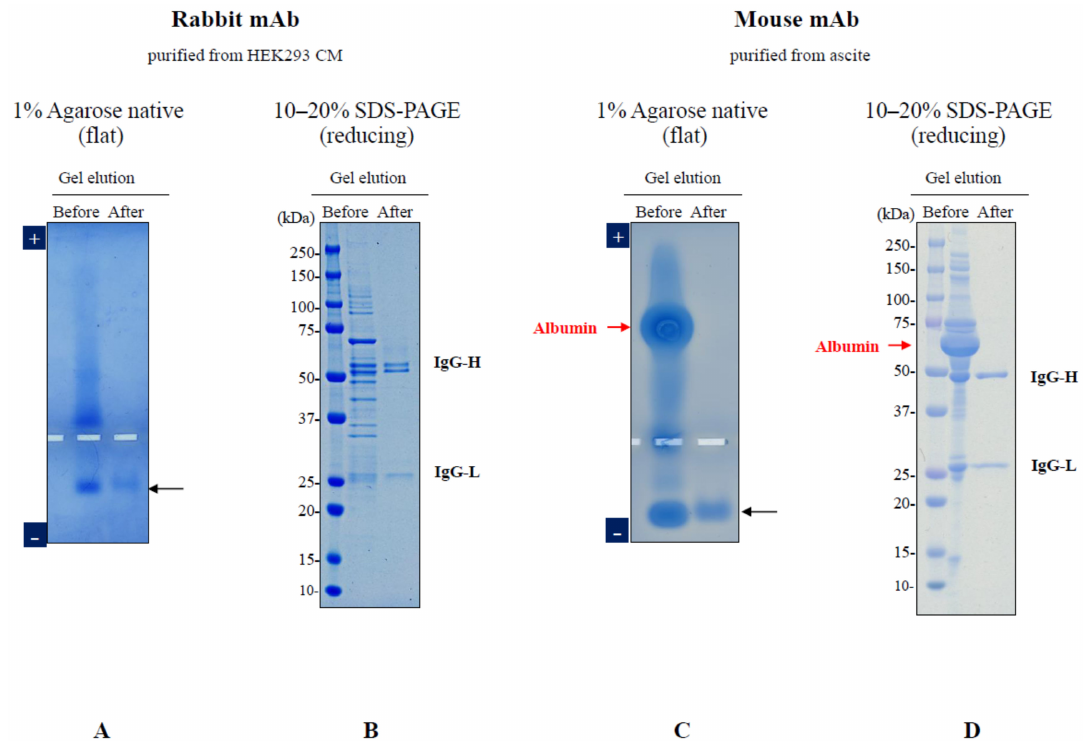
Figure 3. Electrophoresis of antibodies before and after electrophoresis and extraction. Agarose native gel electrophoresis (1% UltraPure agarose gel) was performed on the culture medium containing the rabbit monoclonal antibody expressed in HEK293 cells or the mouse ascites containing the mouse monoclonal antibody. The antibody migrated to the cathode side, while the impurities migrated to the anode side, leading to separation of the antibody. After confirming the migration position via CBB staining of a lane, an agarose slice containing the antibody was excised and used to extract the antibody. Antibodies (1–2 µ g/lane) before and after extraction were analyzed using two different electrophoresis methods. ( A ) 1% UltraPure agarose native gel electrophoresis at 100 V for 50 min for rabbit antibody. ( B ) 10–20% SDS-PAGE under reducing conditions at 30 mA for 50 min for the rabbit antibody. ( C ) 1% UltraPure agarose native gel electrophoresis at 100 V for 60 min for the mouse antibody. ( D ) 10–20% SDS-PAGE under reducing conditions at 30 mA for 50 min for the mouse